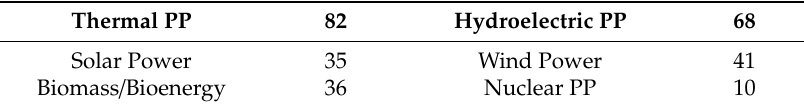
Table 2. Number of di ff erent types of power plants in